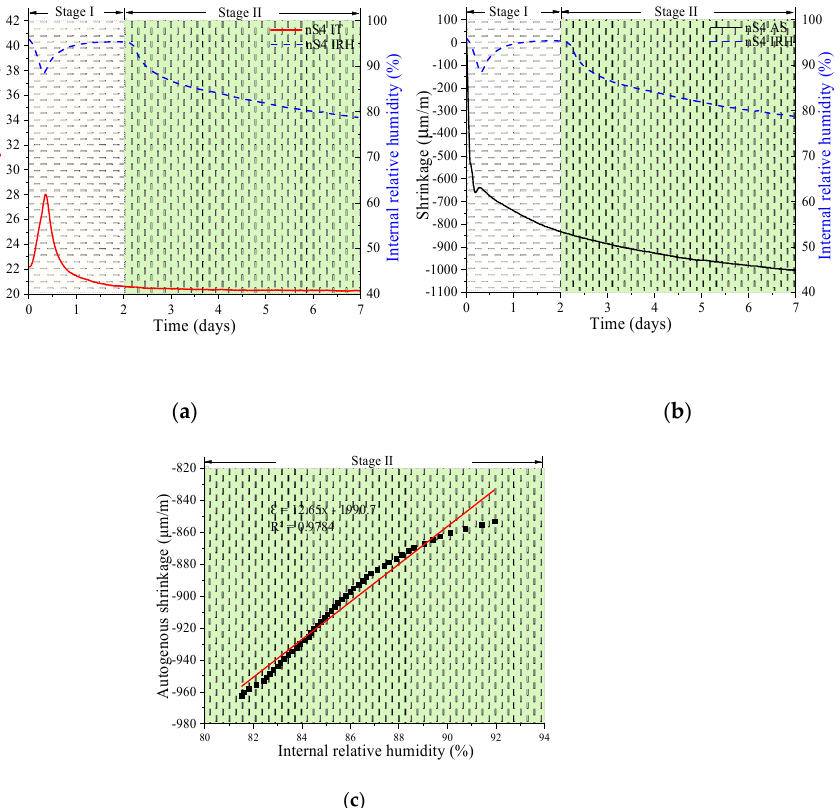
Figure 7. Development of the IRH and IT ( a ) and autogenous shrinkage ( b ) with the age of the nS4 specimen. Linear regression results ( c ) of the IRH and autogenous shrinkage of the nS4 specimen in stage II.